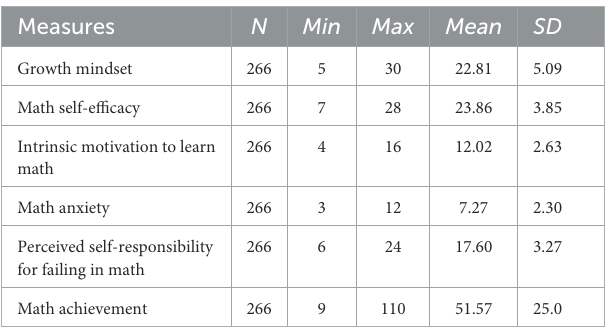
TABLE 1 Summary of descriptive statistics.